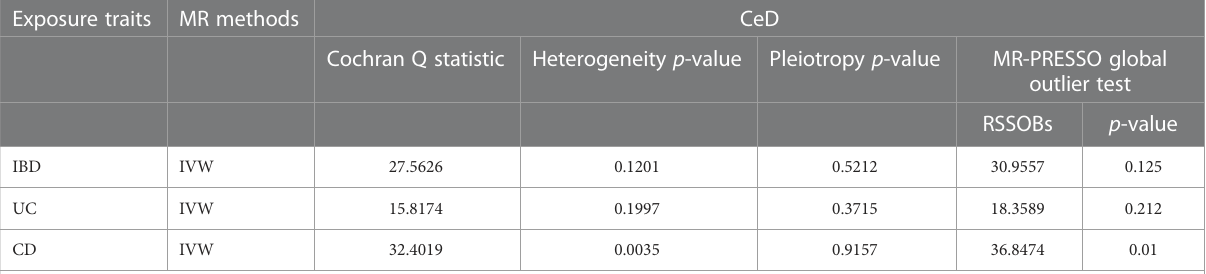
TABLE 3 Heterogeneity and pleiotropy analysis of IBD, UC, and CD with CeD using different analytical methods. Exposure traits